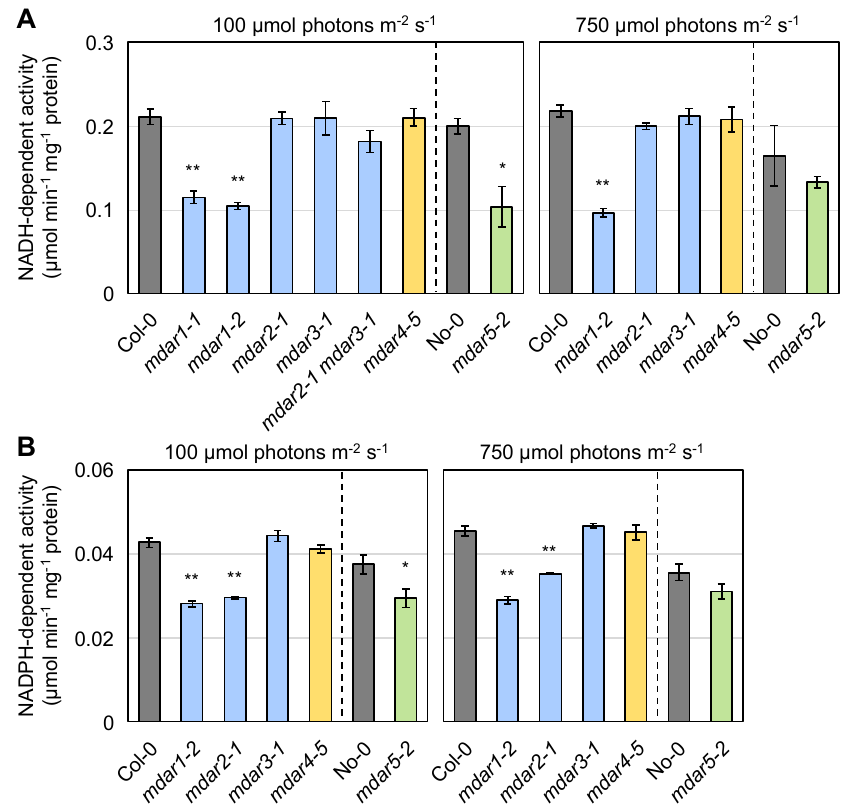
Figure 3. Extractable MDAR activity in the shoots of Arabidopsis thaliana knockout mutants. Arabidopsis thaliana wild-type plants (Col-0 and No-0) and knockout mutants were grown on half-strength MS medium containing 1% sucrose for 2 weeks and then subjected to moderate light (750 µmol photons m −2 s −1 ) for 24 h. ( A ) NADH- and ( B ) NADPH-dependent MDAR activities in the soluble fractions of the shoots were measured. Data are presented as the mean ± SE of at least three biological replicates. Significant differences among genotypes: * p < 0.05, ** p < 0.01 vs. Col-0 or No-0. Student’s t -test was applied to compare No-0 and mdar5-2 , while Dunnett’s test was used for the other comparisons.